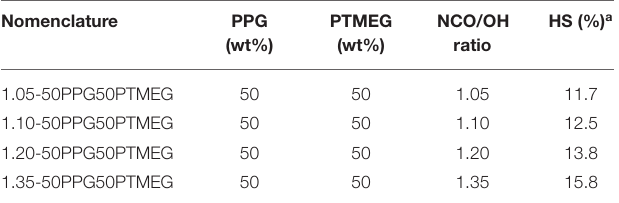
TABLE 1 | Nomenclature and composition of the poly(ether-urethane)s synthesized with 50 wt% PPG + 50 wt% PTMEG blend and different NCO/OH ratios.